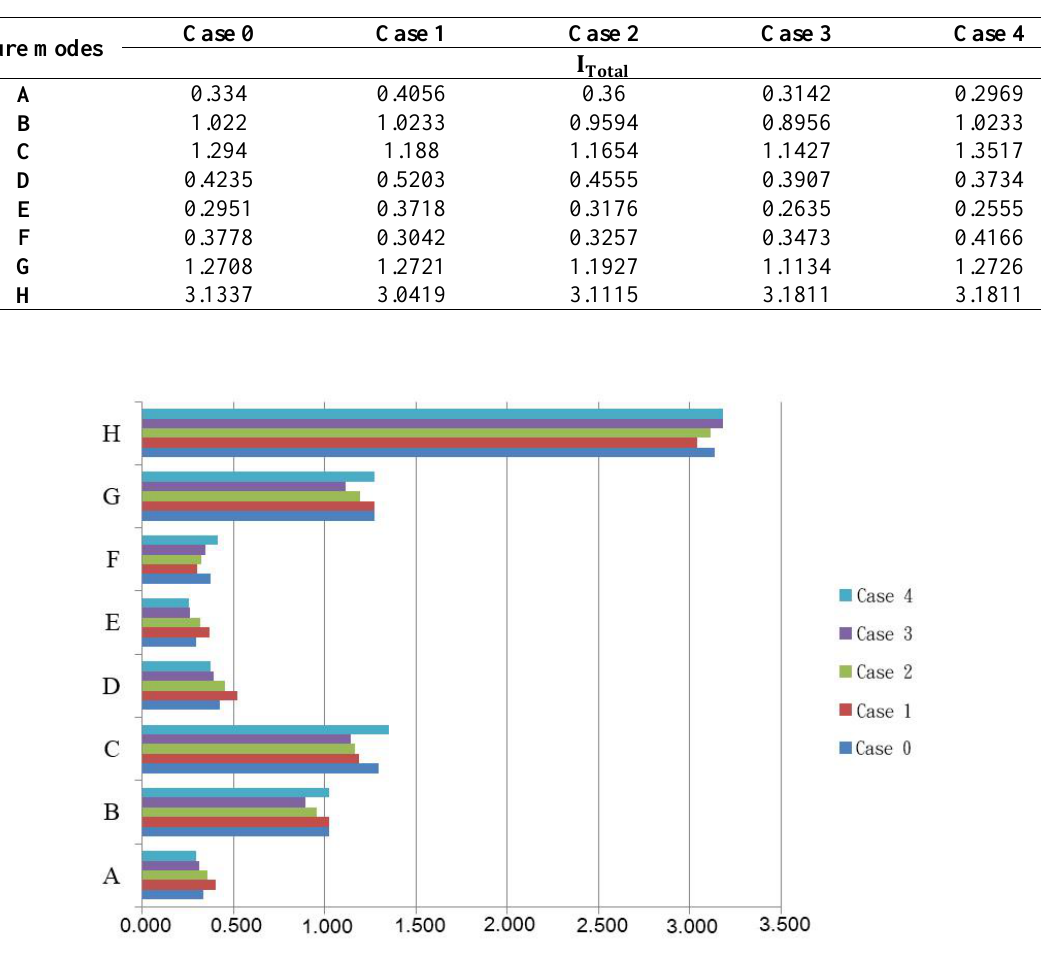
Figure10. Sensitivity analysis